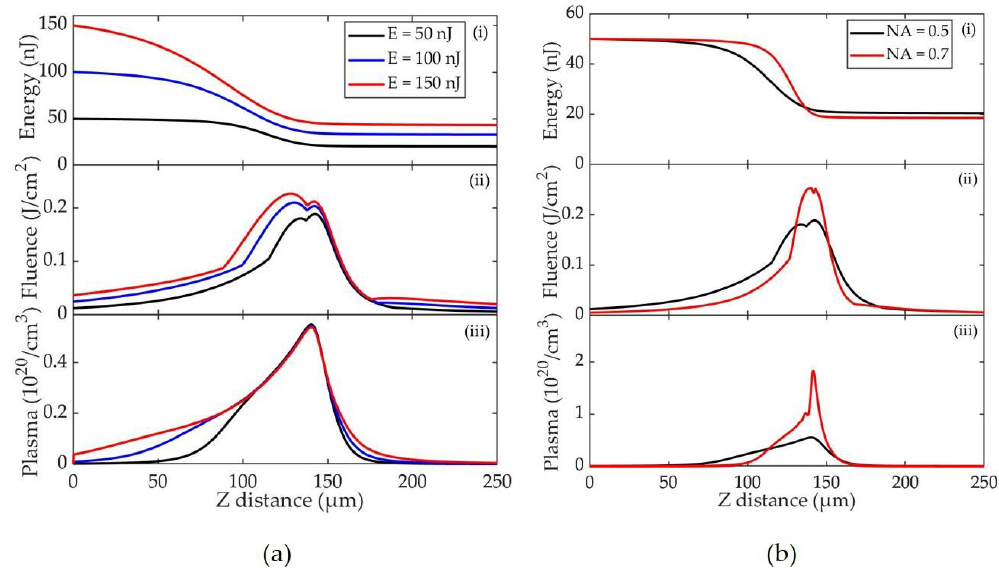
Figure 1. UPPE simulation for silicon: evolution of ( i ) pulse energy, ( ii ) fluence, and ( iii ) plasma density along the propagation direction of a laser pulse for different ( a ) input energy, and ( b ) numerical aperture (NA) of the focusing optics.